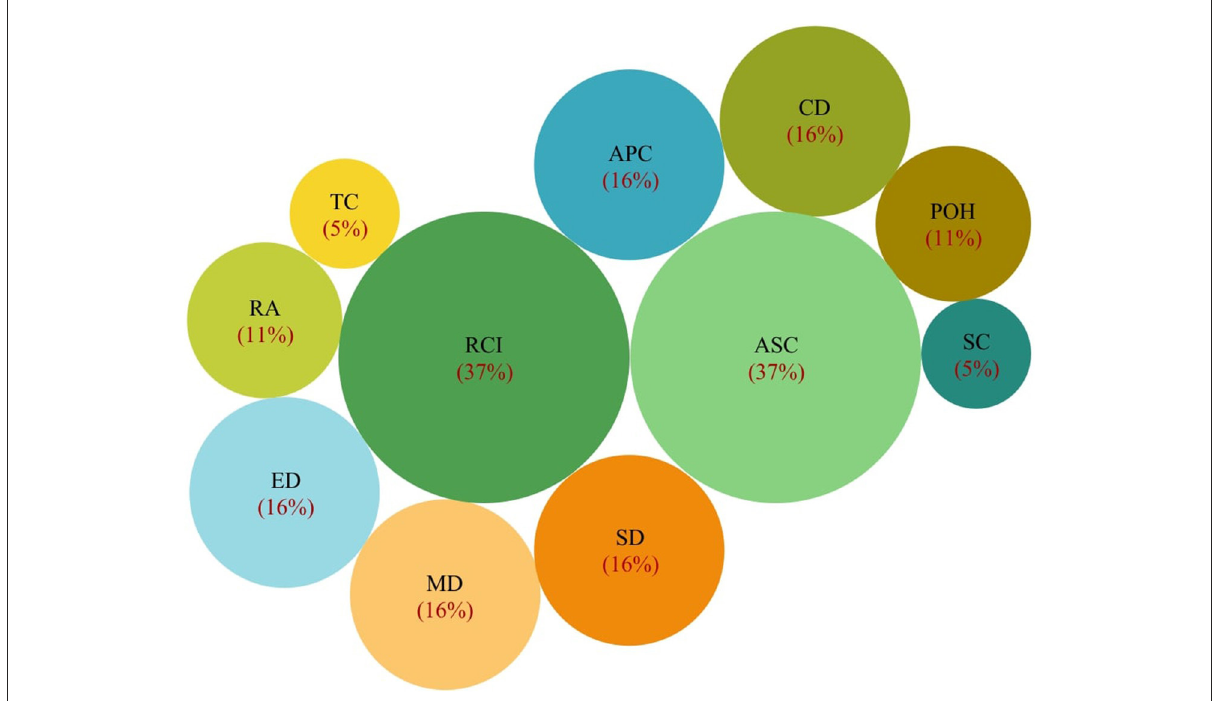
FIGURE3 Bubble graph showing the percentage of articles vs. comparison metrics